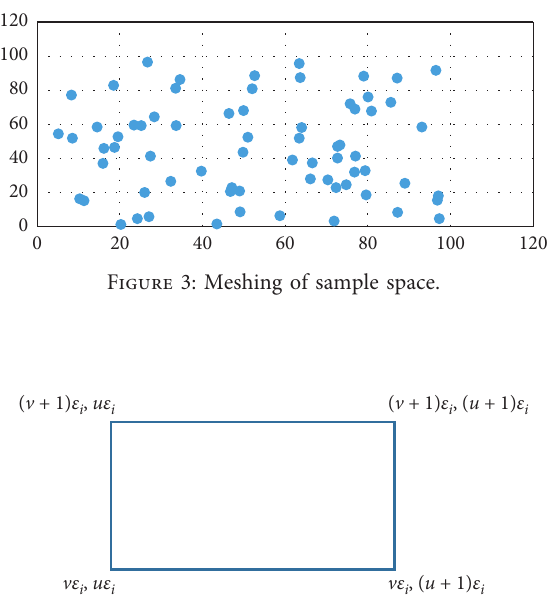
Figure 4: Mesh coordinates of sample